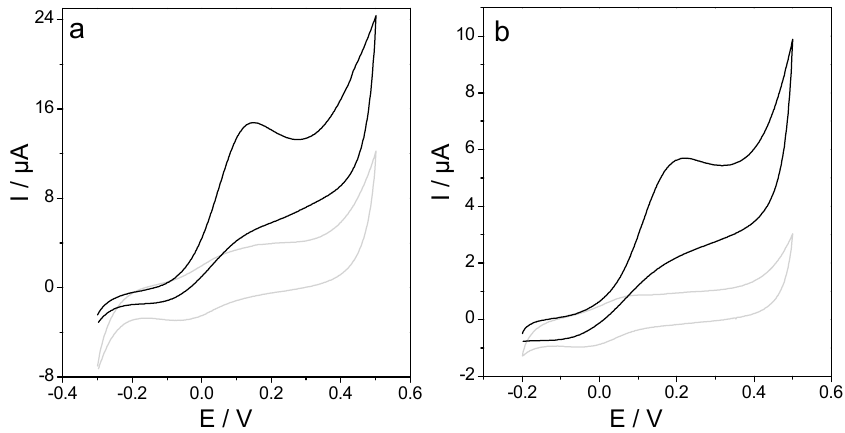
Figure 3. ( a ) Cyclic voltammogram of 3,4DHS–AuNP/SPCE in 0.1 M phosphate buffer (pH 7) in the absence (grey line) or presence (black line) of 1.0 mM of H 2 O 2 ; ( b ) Cyclic voltammogram of lactate oxidase (LOx)/3,4DHS–AuNP/SPCE in 0.1 M phosphate buffer (pH 7) in the absence (dotted line) or presence (solid line) of 0.5 mM lactate. Scan rate: 0.01 V·s − 1 .